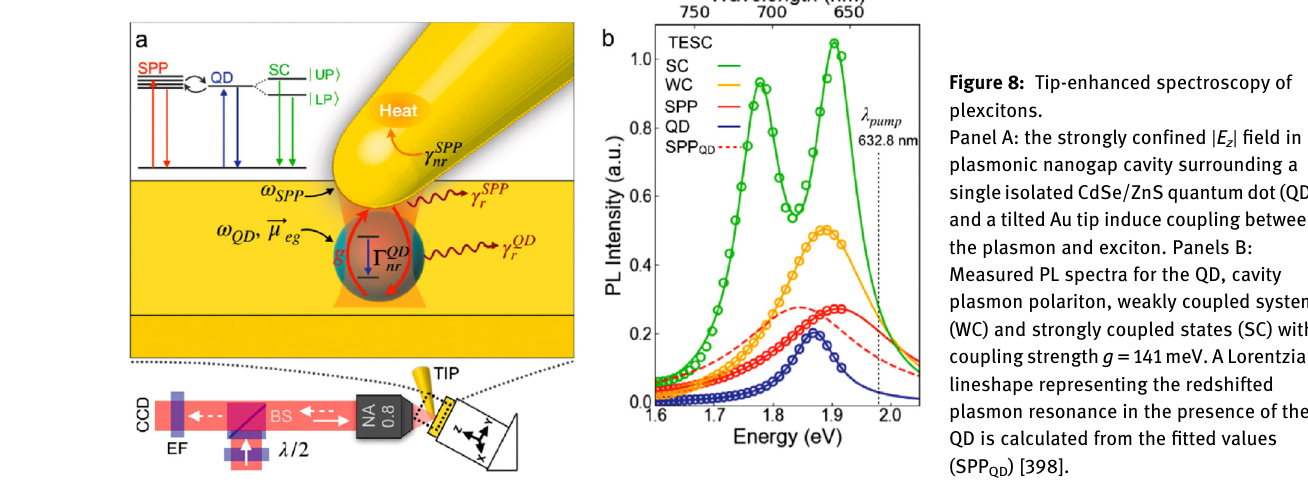
[437, 438]. Moire superlattices of plasmon polaritons (Figure 6) present yet another example of polaritonic lat- tices. Moire superlattices were realized in graphene devices with nanostructured gate electrodes [439], as well as in moire superlattices of twisted graphene layers [308]. Polaritonic interference, refraction, collimation, front shaping, and waveguiding. All these common wave phe- nomena are relevant to polaritons (Figure 9). In van der Waals materials, domain wall boundaries can act a polar- itonc re fl ectors [440 – 442], or conductors [443]. Zia and